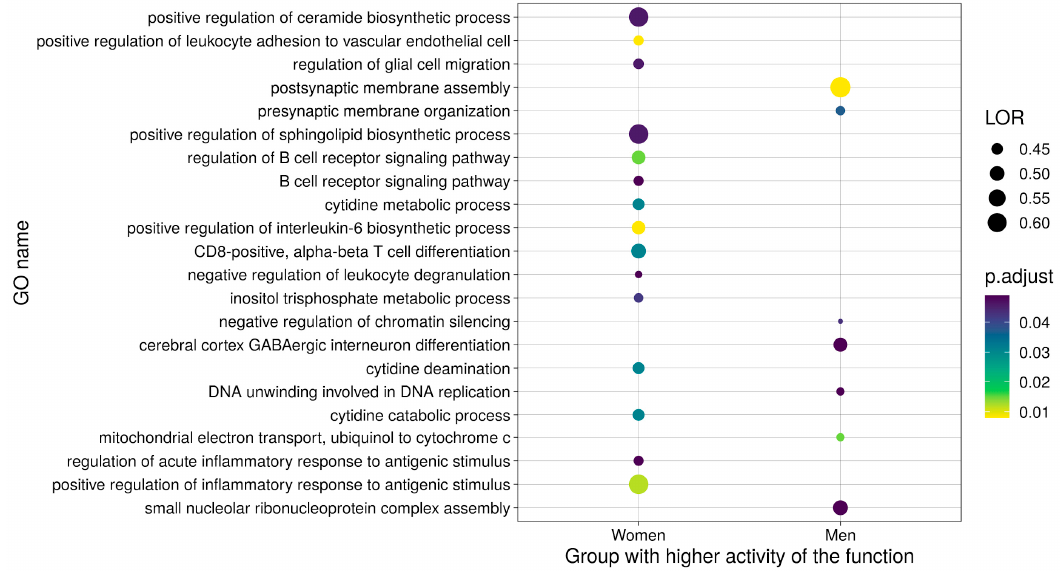
Figure 4. Summary dot plot of GO biological processes (BP) meta-analysis results. Only those significant terms with a log odds ratio (LOR) over 0.4 are shown.